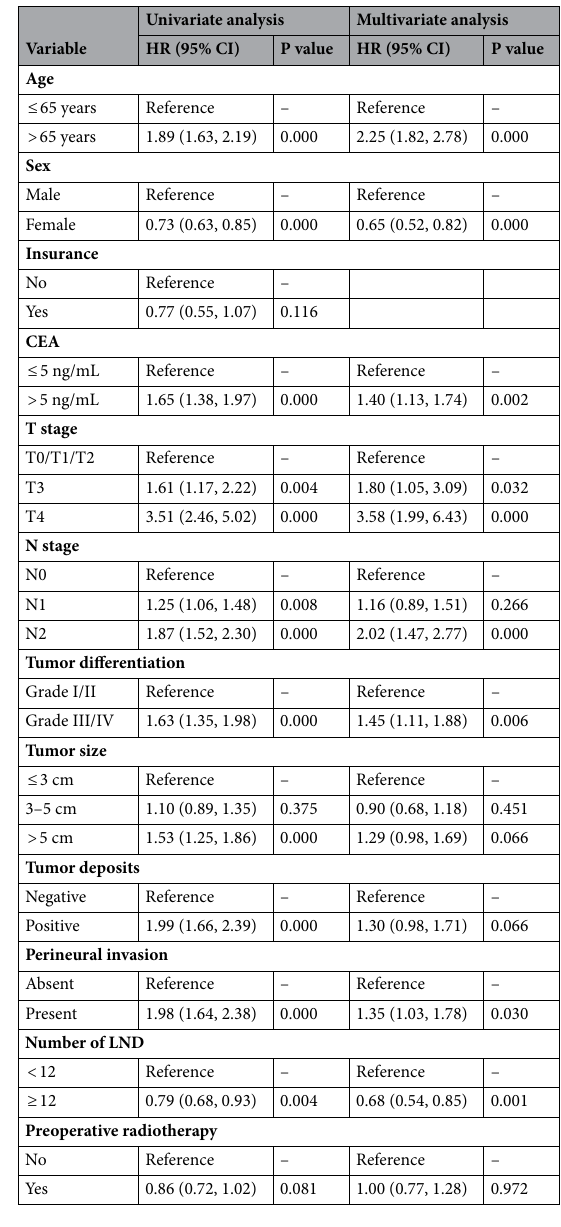
Table 2. Univariate and multivariate analysis of prognostic factors associated with overall survival (training set). CEA carcinoembryonic antigen, LND dissected lymph nodes, HR hazard ratio, CI confidence